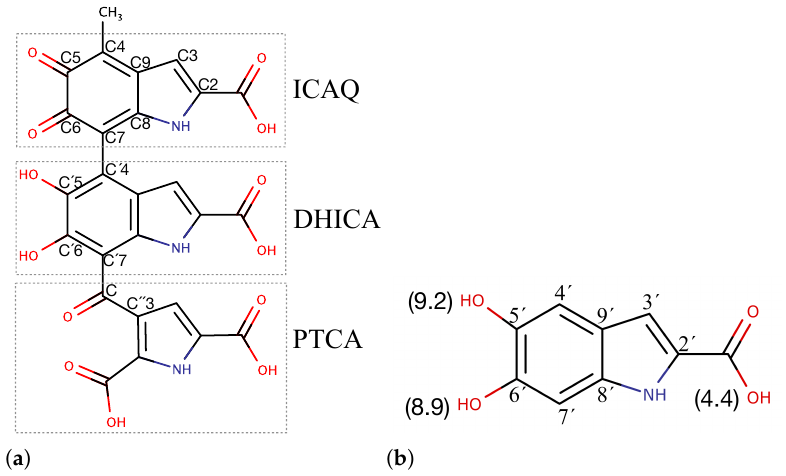
Figure 1. ( a ) The chemical structure of the uncharged eumelanin model (DHICA-eumelanin): the ICAQ (DHICA’s tautomer), 5,6-dihydroxyindole-2-carboxylic acid (DHICA), and pyrrole-2,3,5- tricarboxylic acid (PTCA) moeities. In addition to uncharged DHICA-eumelanin, deprotonated DHICA-eumelanin corresponding to physiological pH was simulated. Due to the PKa value of the DHICA moiety ( b ), all four carboxylic groups deprotonate, and the molecule obtains a net charge of − 4